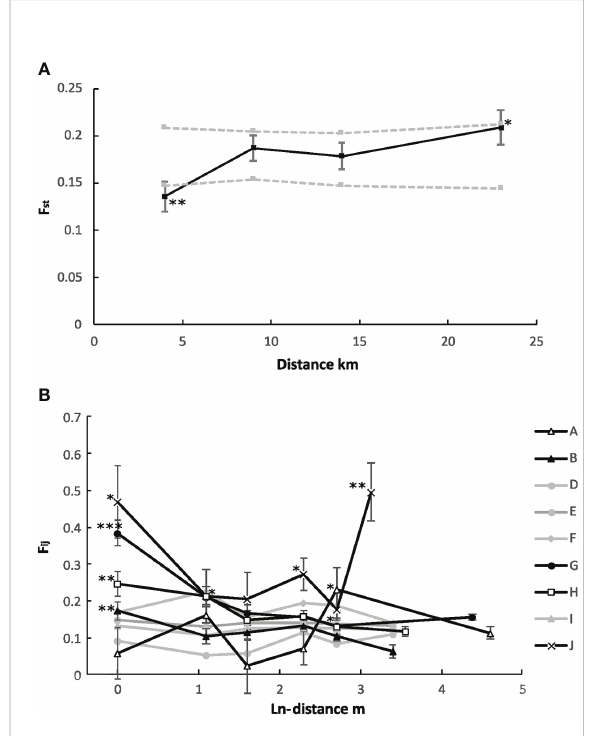
FIGURE 2 Spatial correlations among and within Ruppia spiralis populations along the analyzed western coast of Sicily (Italy). Rescue are displayed with discrete distance classes (with *** at p < 0.001; ** at p < 0.01; * at p < 0.05 signi fi cance level). (A) A mantel test of pairwise differention (F st ) over four distance classes. Dotted grey lines represent upper and lower con fi dence intervals at 95%. (B) Autocorrelation of individuals within populations as pairwise kinship (F ij ) over In-distance. Black lines represent populations with signi fi cant FSGS, whereas grey lines represent non-signi fi cant